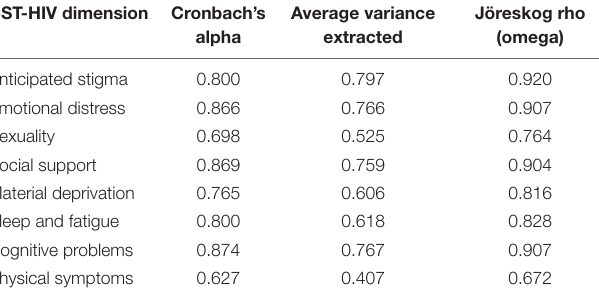
TABLE 6 | Construct and reliability statistics of the CST-HIV